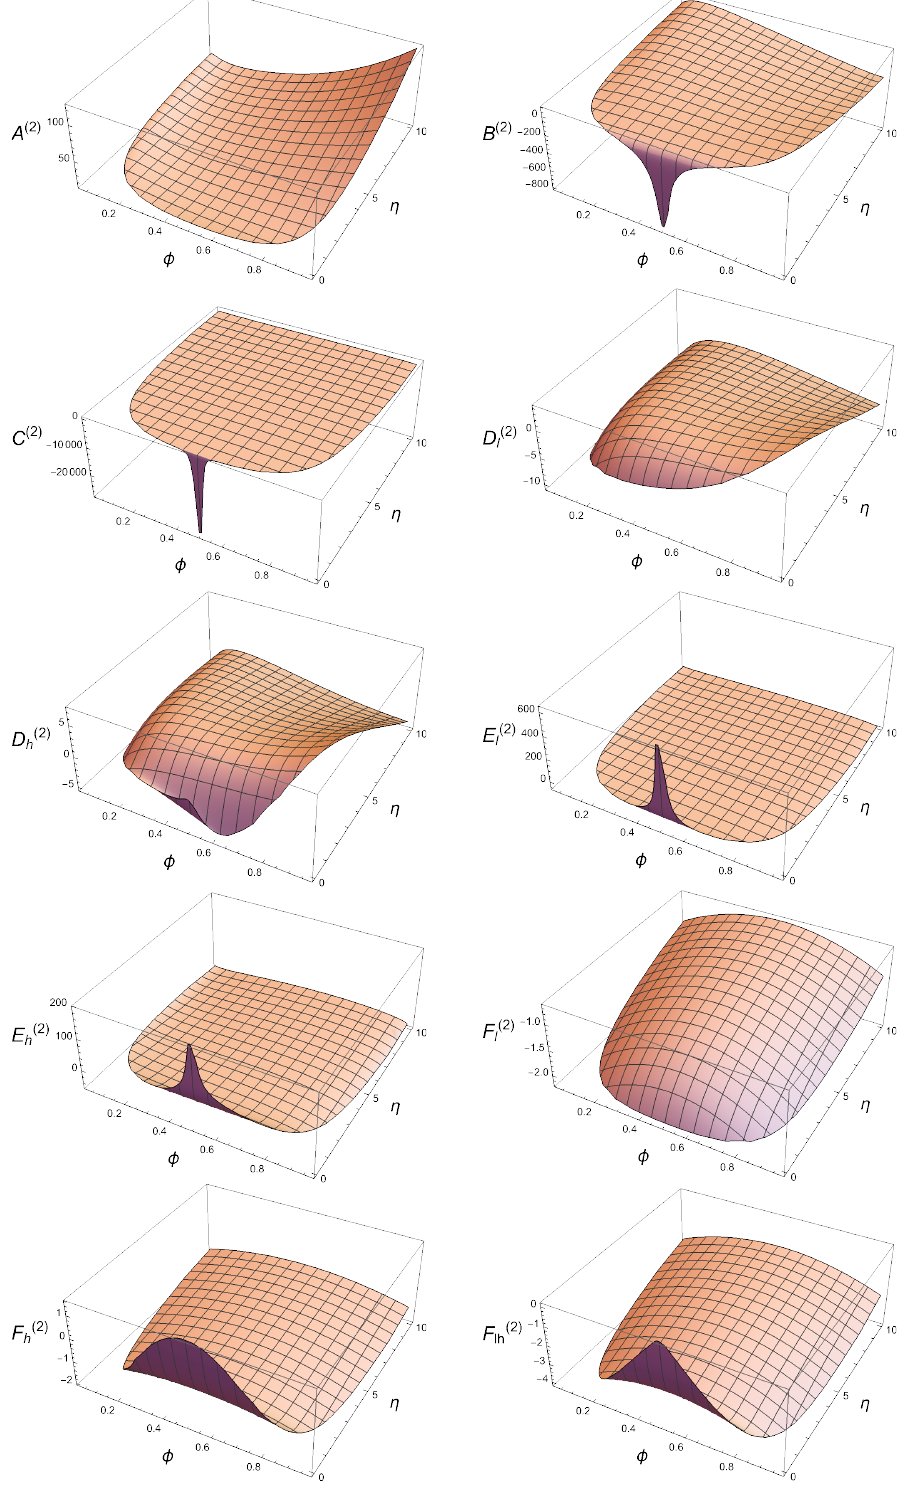
Figure 12 . Three-dimensional plots of the coefficients (finite part) appearing in the decomposition of the renormalised two-loop amplitude in eq.